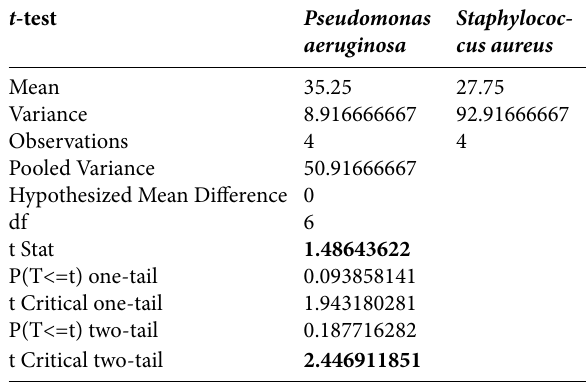
Table 3: Statistical measurements of the diameter of zone of inhibi- tion of four samples of Pseudomonas aeruginosa and Staphylococcus aureus by implying two-tail t -test.